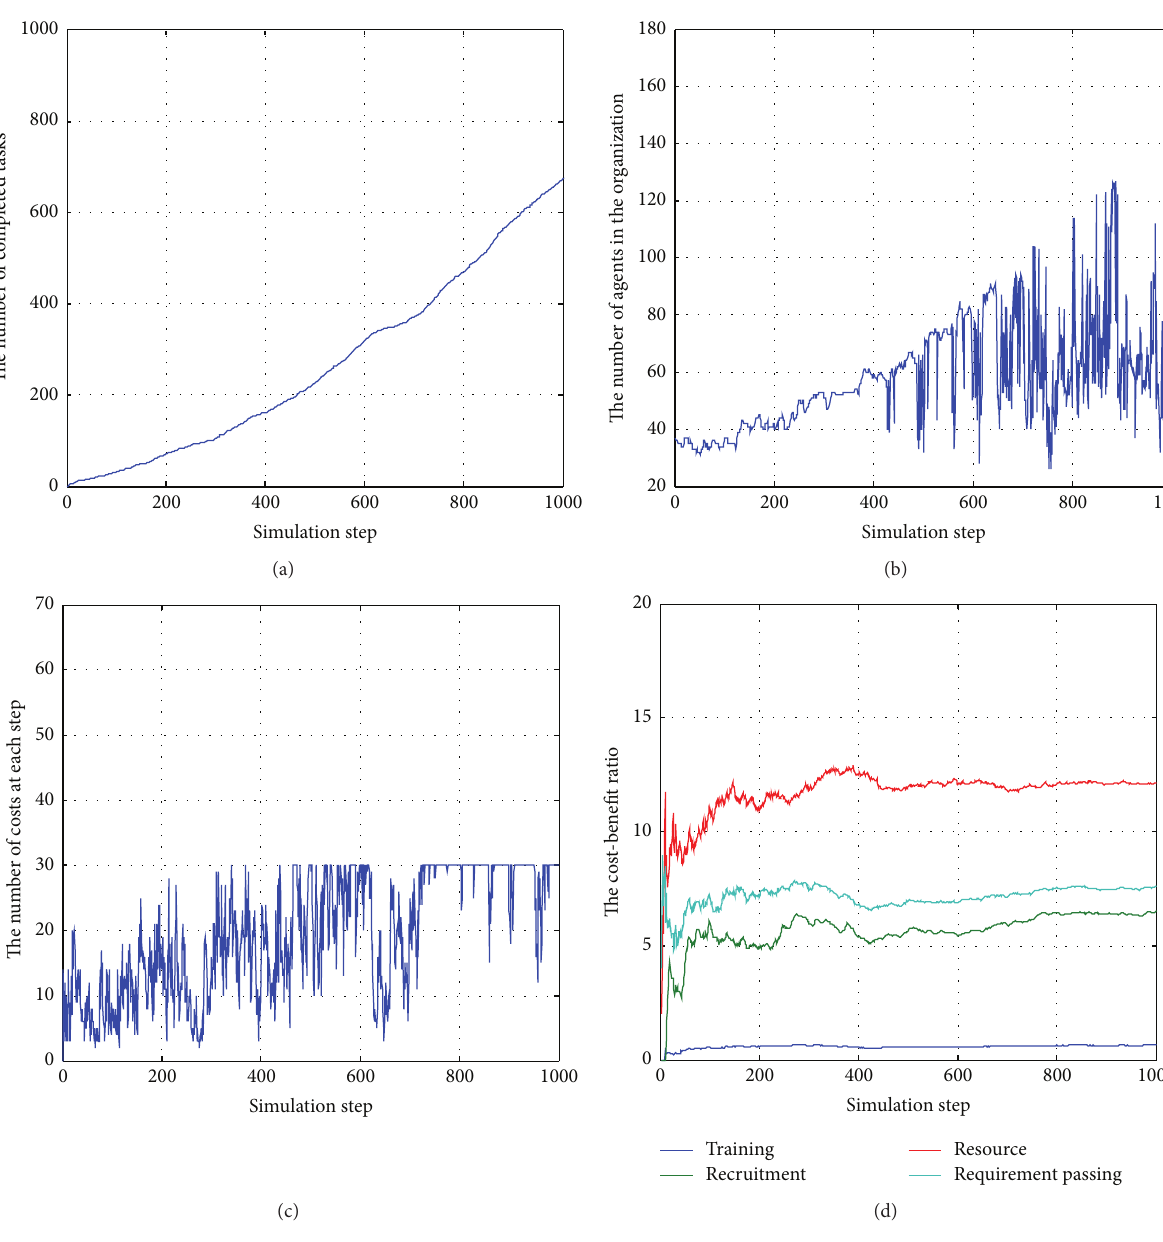
Figure 11: The organizational performance in a limited environment.